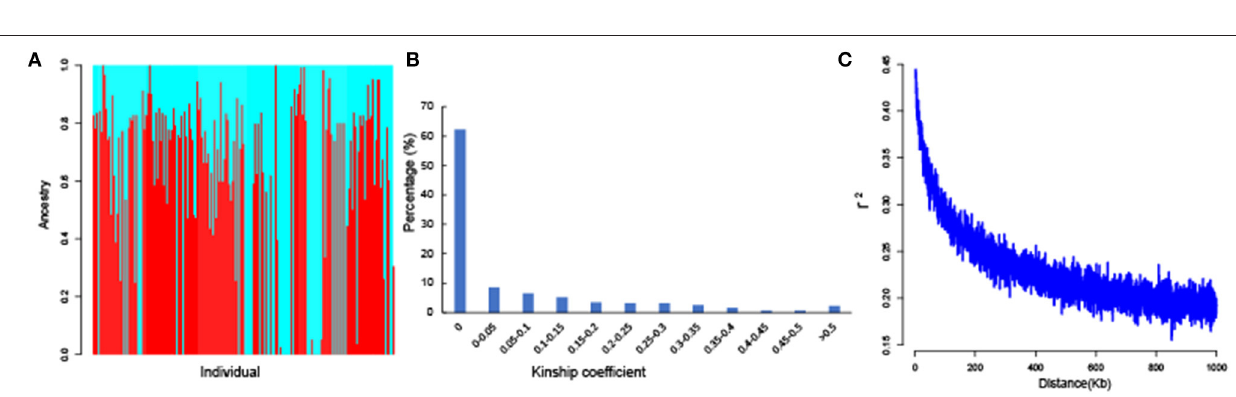
FIGURE 3 | The results of population structure, kinship coefficients, and linkage disequilibrium (LD) decay of 189 G. hirsutum accessions. (A) The total panel was divided into two subgroups, and each color represents one subgroup. (B) Histogram of the frequency distribution of pairwise relative kinship coefficients. (C) Genome-wide average LD decay estimated for the whole